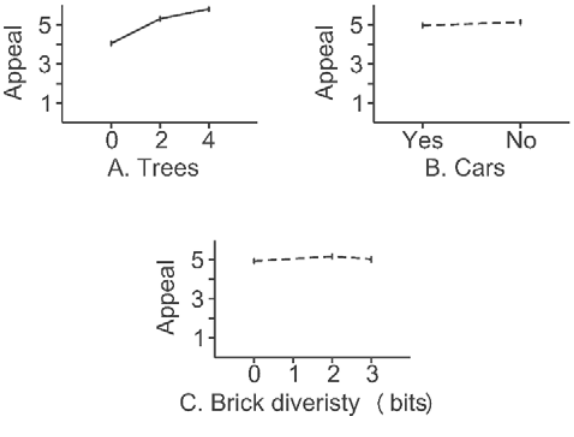
Figure 10. Results for “New” Amsterdam. Solid lines indicate contrasts that achieved the individual “ p < 0.05” level of significance. Dotted lines indicate contrasts that did not achieve the individual “ p < 0.05” level of significance.